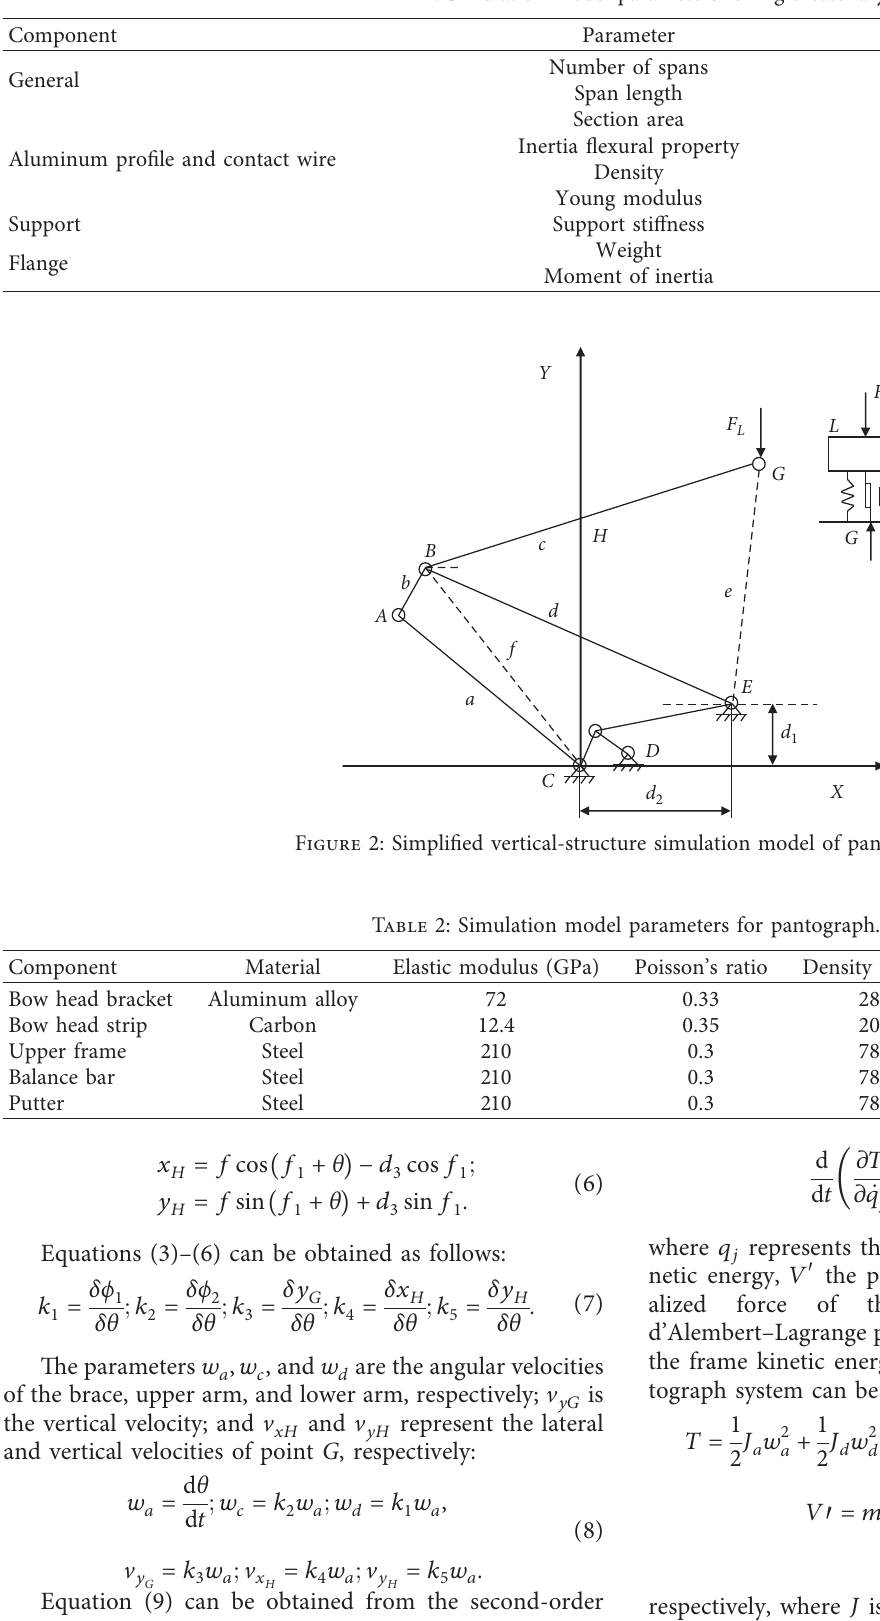
Table 1: Simulation model parameters for rigid catenary.